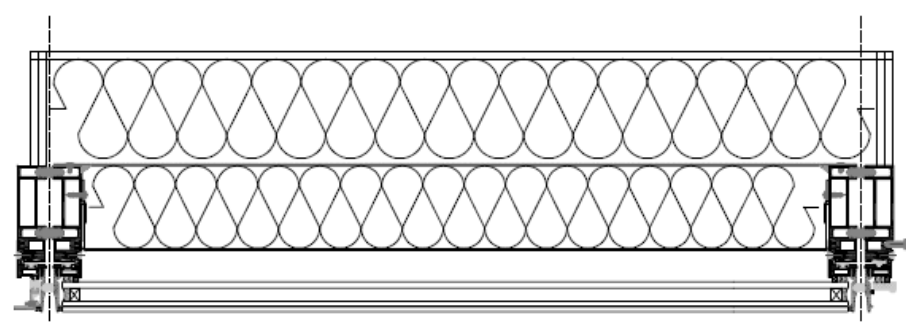
Fig. 6: shadow box – with transparent glass